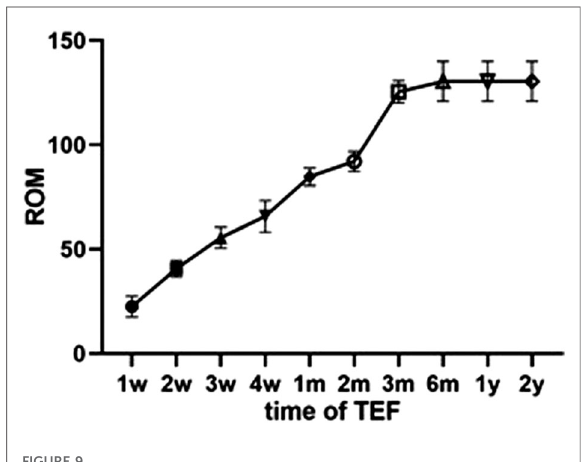
FIGURE 9 Changes of range of motion of knee joint after TEF